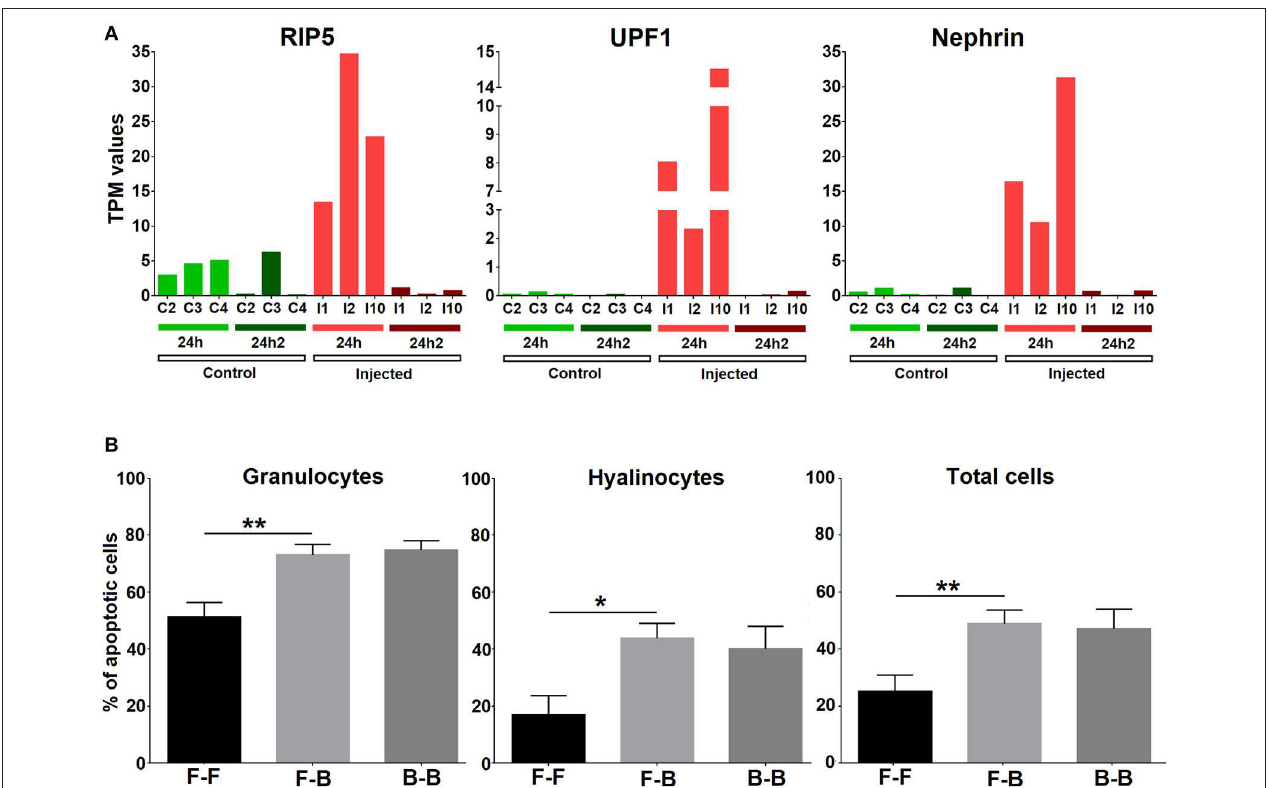
FIGURE 7 | (A) Expression values (TPM) for three representative apoptosis inducers (RIP5, UPF1, and nephrin) in the 6 studied individuals (C2, C3, C4, I1, I2, and I10) at two experimental time points (24 hpi and 24 hpi2). (B) Apoptosis analysis. Bars represent the mean percentage and standard error of apoptotic cells in total hemocytes, hyalinocytes and granulocytes in eight individual mussels. Asterisks show the statistical significance: * p < 0.05 and ** p < 0.001. Subsequent stimulations are indicated as follows: F-F, FSW and FSW; F-B, FSW and bacteria; B-B, bacteria and bacteria.